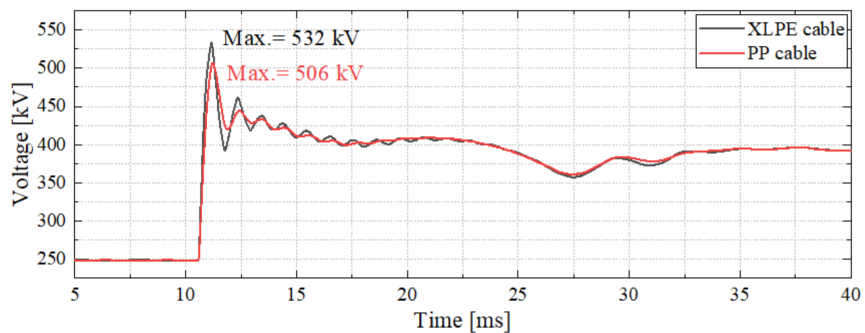
Figure 9. Overvoltage simulation results according to cable